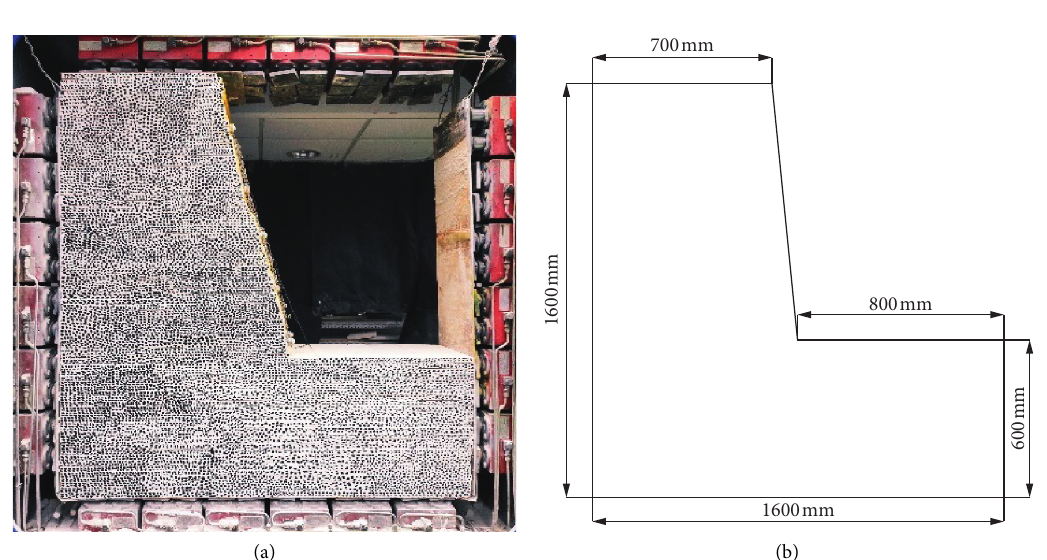
Figure 4: Physical model test diagram: (a) lateral view; (b) model geometry.